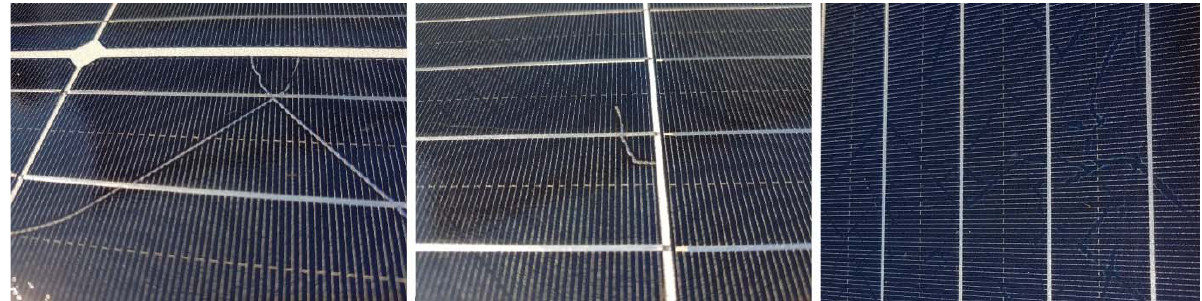
Figure 28. Observed damage determined by visual inspection of the module.